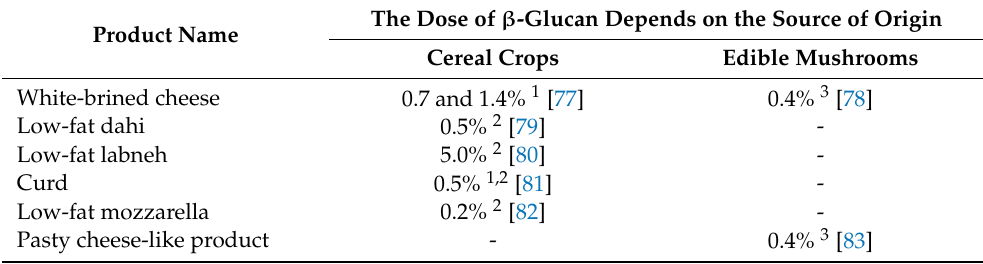
Table 3. Recommended dosages of β -glucan of different origins in cheeses and cheese-like products.